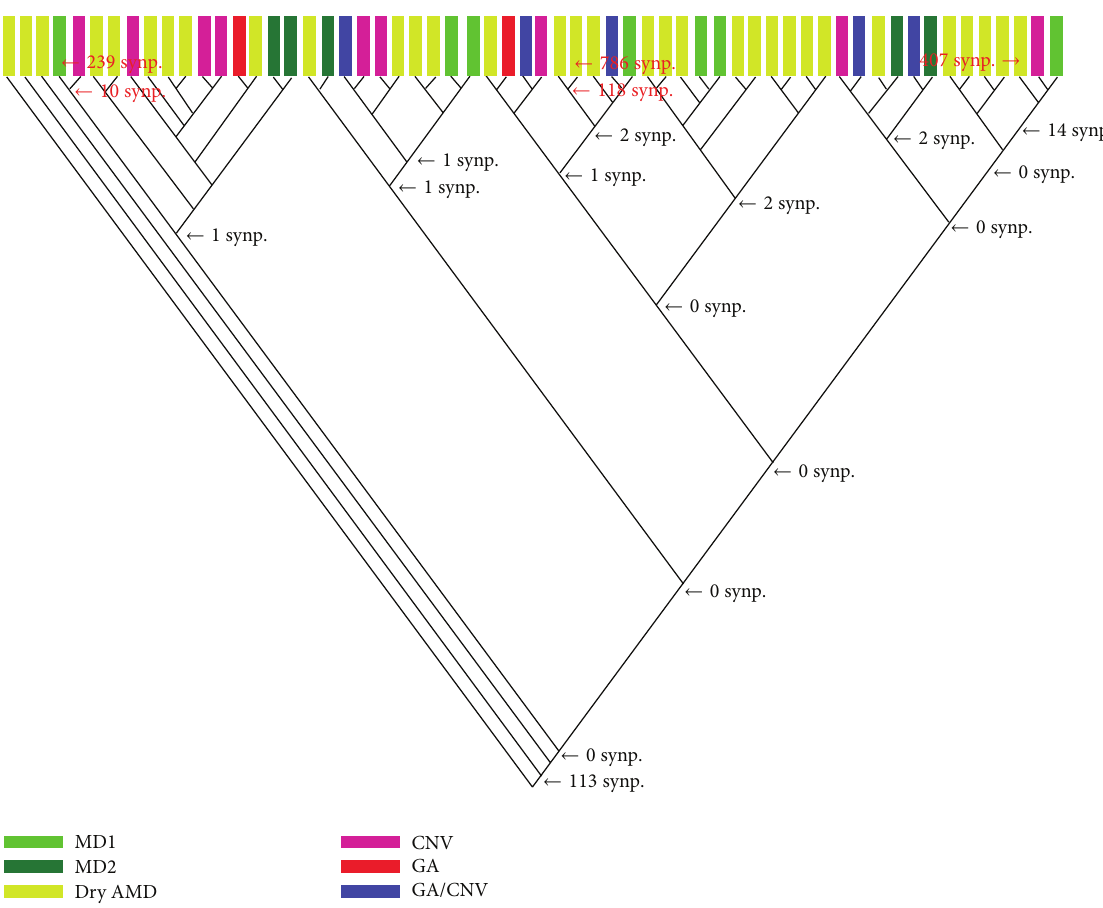
Figure 1: Cladogram of retinal specimens. The number of synapomorphies for major nodes is indicated to the right of the nodes, as well as for some specimens used as examples in the pathways analysis (numbers in red). Colors indicate AMD phenotypic